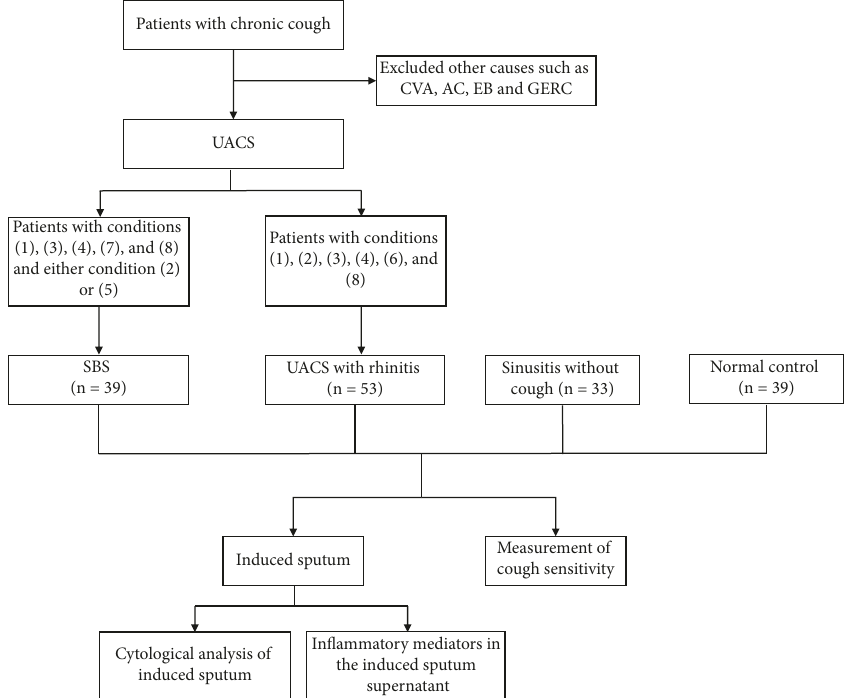
Figure 1: Consort diagram of the patients. (1) Cough course > 8 weeks with normal CTimages; (2) history of chronic rhinitis or sinusitis; (3) one or more specific symptoms (sensation of secretions dripping down into the throat, throat-clearing sign, nasal discharge, nasal ob- struction, or sneezing); (4) one or more specific signs (erythema and “cobblestone” appearance of the posterior pharyngeal mucosa, or mucoid/purulent secretions dripping into the pharynx); (5) mucosal blur/thickening > 6mm, or an air-fluid level on a radiograph of the sinuses; (6) oral administration of H1-receptor antagonists (cetirizine, 10 mg, once-daily) with cough disappearance; (7) chronic sinusitis that was treated efficaciously with macrolide drugs (erythromycin, 250mg, b.d.); (8) other causes of chronic cough were